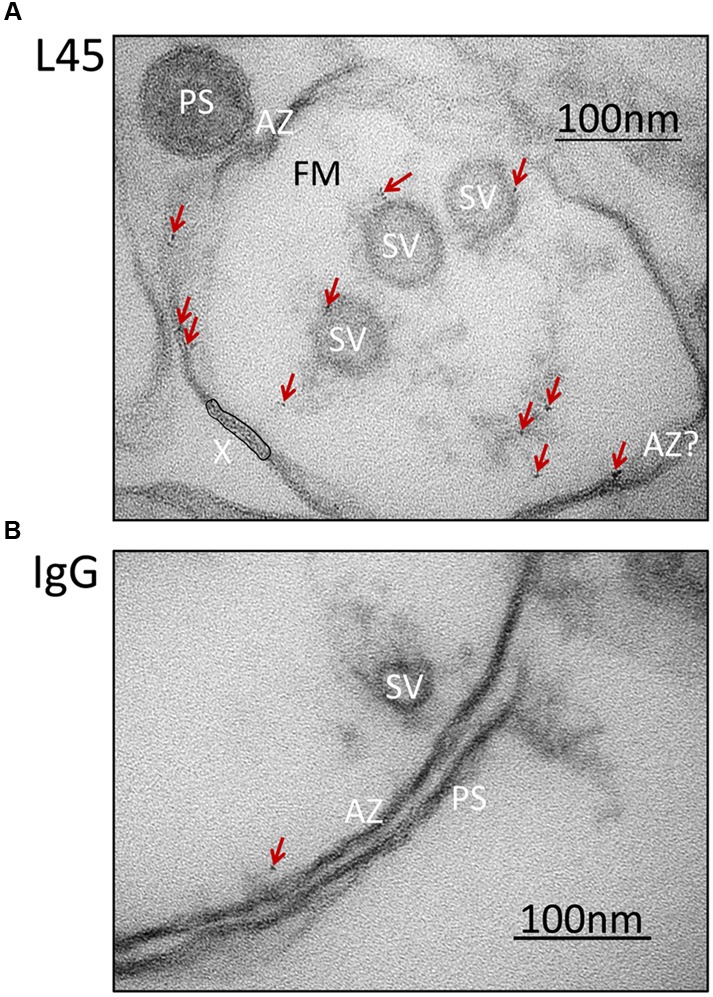
Synaptosome ghosts immunogold labeled with an antibody against the tip of the CaV2.2 C-terminal. SSM ghosts were first cryoloaded with primary L45 (A) or non-specific rabbit IgG control (B) as in Figure 2B. With L45-cryoloaded ghosts nanogold particle clusters (denoted by crimson arrows) were observed on SVs and active zone membrane (AZ). Ghosts that were cryoloaded with control rabbit IgG (representative image in bottom panel) exhibited fewer gold particle clusters (crimson arrow) and these were not associated with a particular subcellular structure. Labels as in Figure 2A. AZ?, Likely, but unconfirmed active zone; X, region of membrane with false-positive, nanogold-like dark spots (see Materials and Methods, EM Preparation and Imaging).